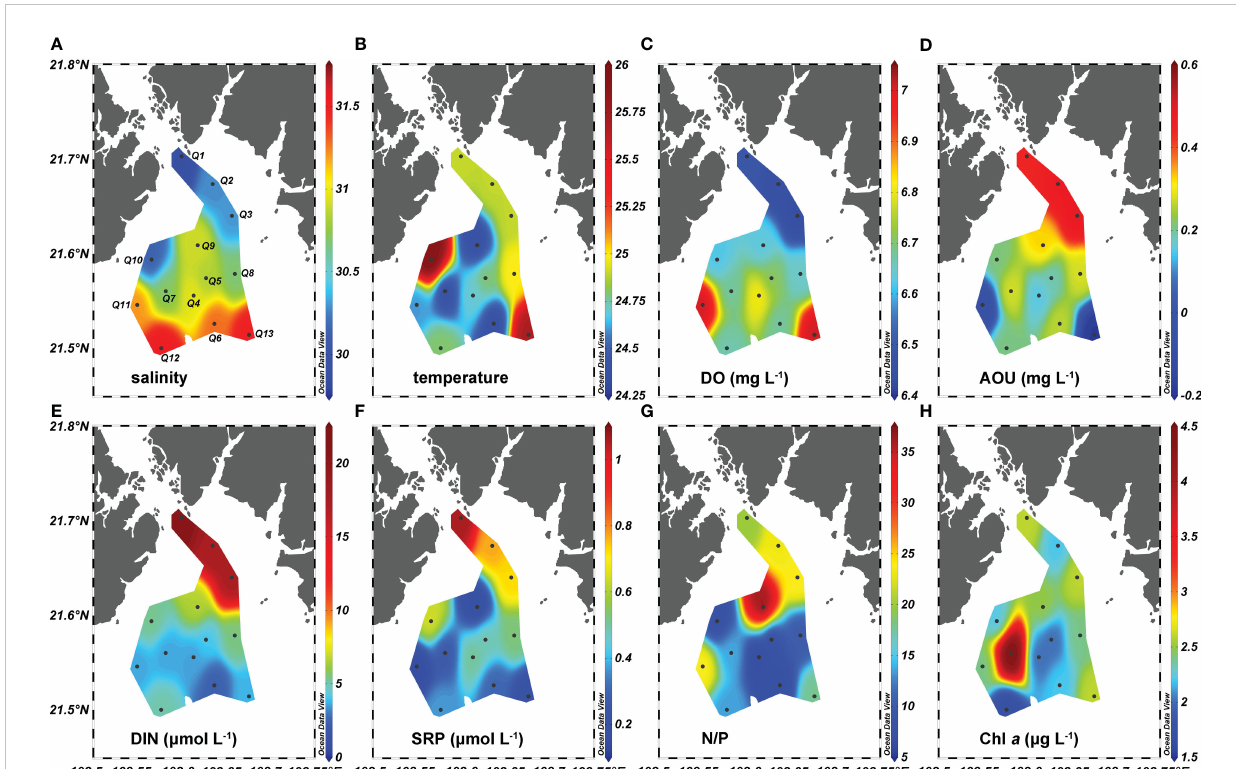
FIGURE 2 Spatial distributions of (A) salinity, (B) temperature, (C) dissolved oxygen (DO), (D) apparent oxygen utilization (AOU), (E) dissolved inorganic nitrogen (DIN), (F) soluble reactive phosphate (SRP), (G) the ratio of DIN and SRP (N/P), and (H) chlorophyll a (Chl a ) in the surface water of Qinzhou Bay. Black dots show the sampling stations and are labeled in (A) .